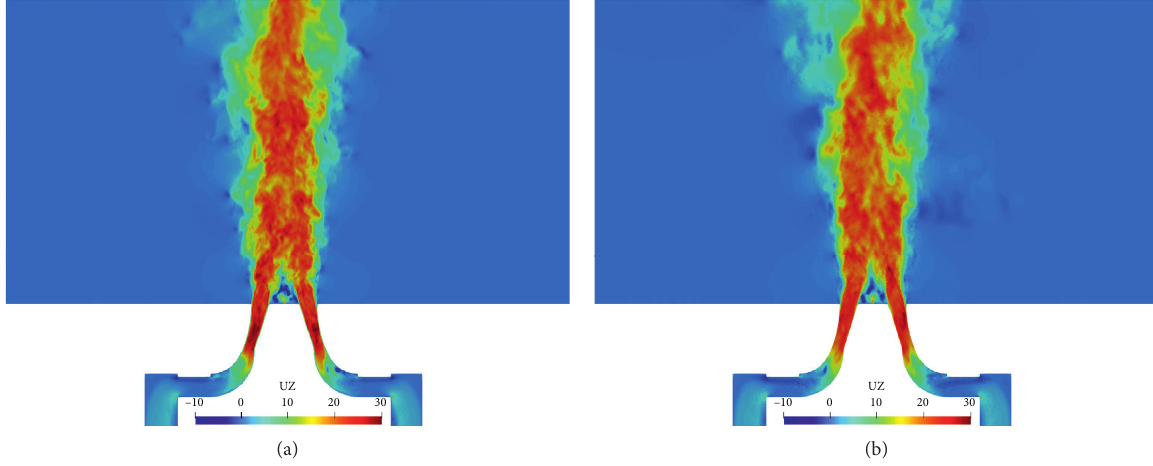
Figure 6: Instantaneous axial velocity fields for cases A-NR (a) and B-NR (b) in the central vertical plane.